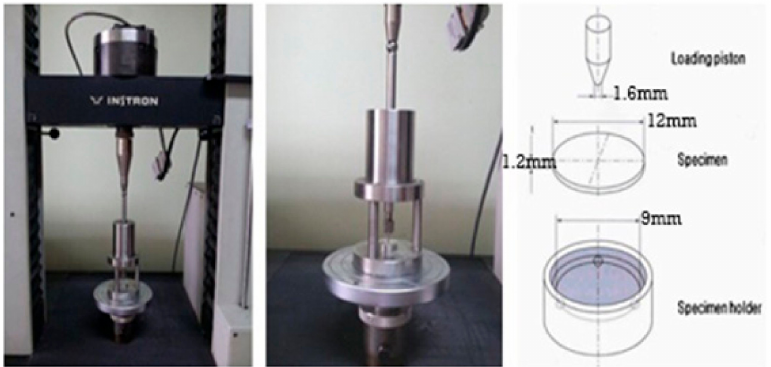
Figure 3. The piston on 3-point biaxial flexural strength test machine and specimen holder size used in this